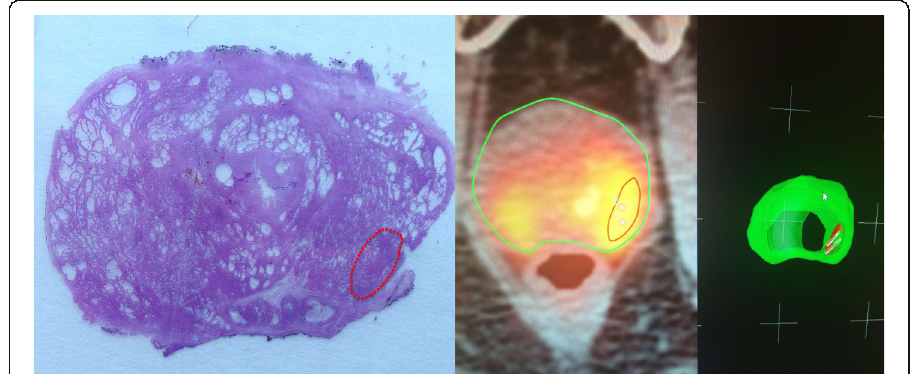
Fig. 2 Left: Whole gland pathological examination. Red dot line indicates the PCa index lesion. Centre: Axial PET-CT/TRUS fusion imaging. Green line is the contour of whole gland and red line the ROI. Right: 3D imaging with biopsy samples (red cylinder)